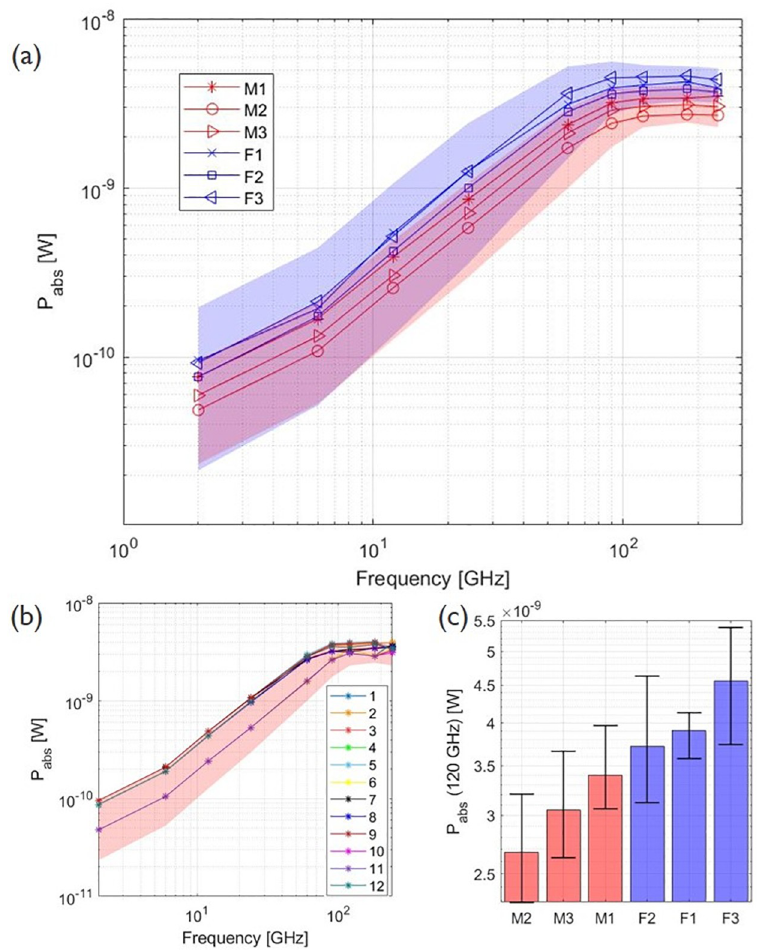
Fig 4. Total absorbed RF power ( P ) by the mosquito as a function of frequency for an incident field strength of abs 1 V/m. (a) The dots present the means of the 12 plane waves, the blue and red shaded regions represent the range of absorbed power for all 12 plane waves for all female and all male mosquitoes respectively. (b) The absorbed powers for mosquito M1 for the twelve different plane waves as illustrated in Fig 1. The red shaded area represents the range of absorbed power for all 12 plane waves for all male mosquitoes. (c) The bar chart shows the total absorbed power ( P abs ) at 120 GHz, the whiskers indicate the range for all 12 plane